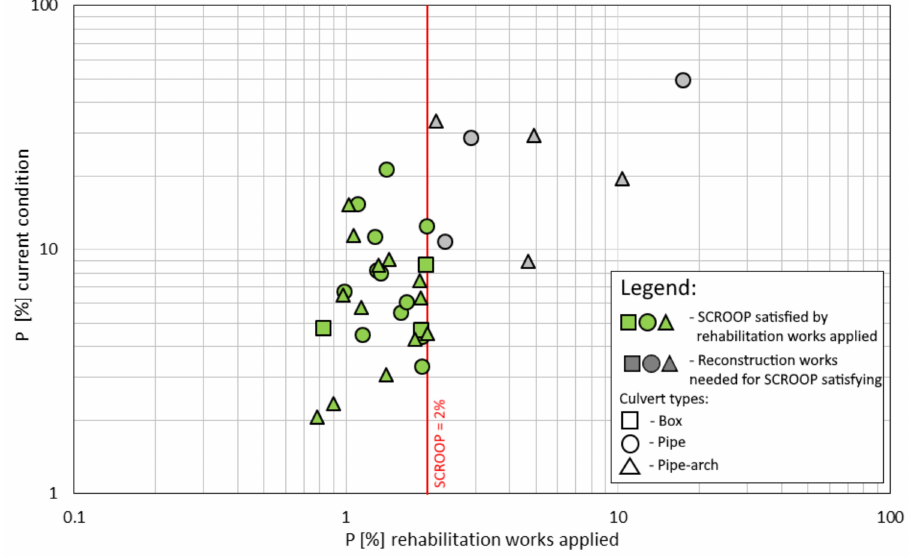
Figure 10. Effects of the culvert rehabilitation works on the fulfillment of